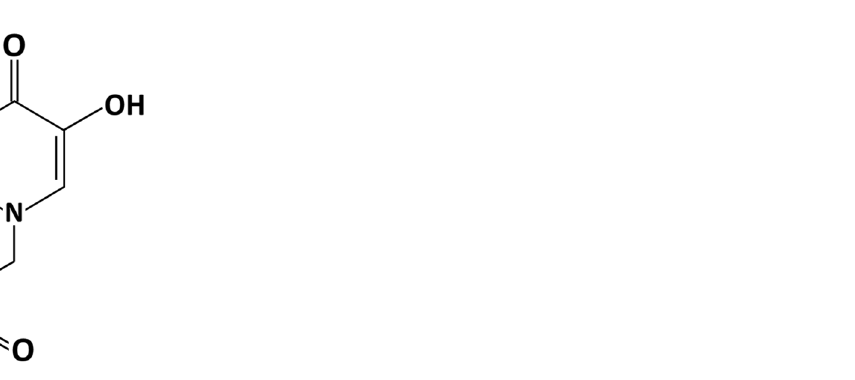
Figure 2. Chemical structure of β -N(3-hydroxy-4-pyridone)- α -amino propionic acid